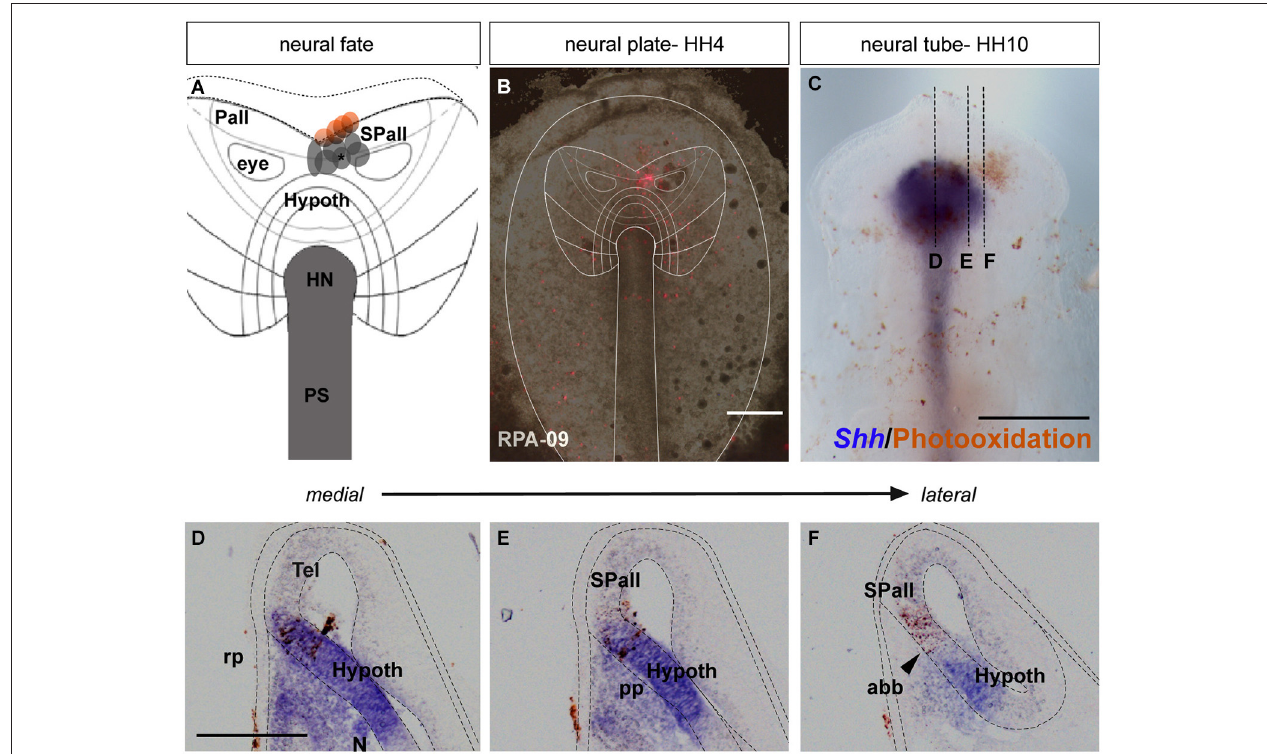
hybridized for Shh (to visualize the hypothalamic basal plate expression), and the DiI was photo-oxidated with DAB. (D–F) Sagittal cryo-sections show that most labeled cells extend dorsoventrally within the rostral neural tube. In mid-sagittal sections, the injection-derived cells partially overlap the Shh positive cells of the hypothalamic basal plate. Laterally, positive cells appear in alar hypothalamic and telencephalic domains, where Shh expression is absent. Scale bars: 250 µ m in (B,C) ; 125 µ m in (D–F)